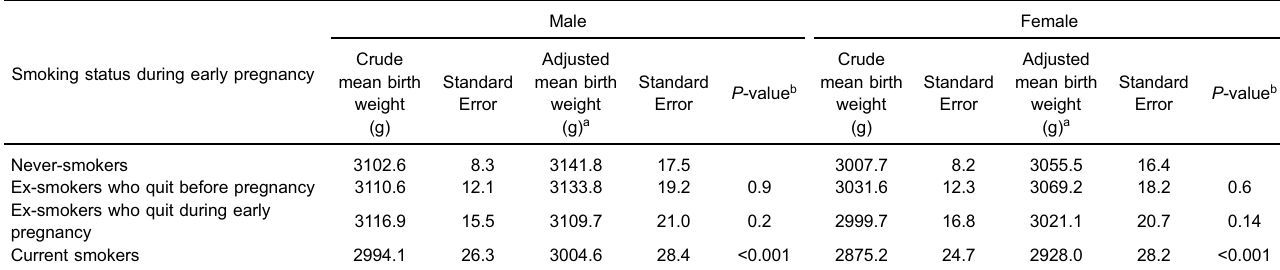
Table 4. Crude and adjusted mean birth weight in male and female infants without preterm birth Male Female Smoking status during early pregnancy